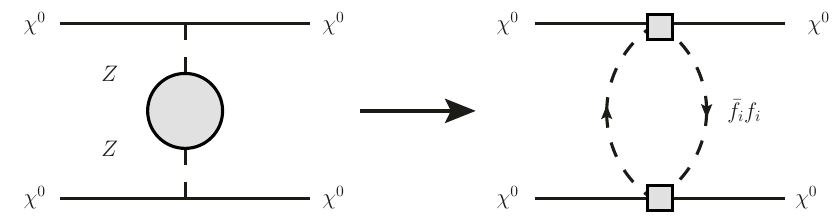
Figure 4 . The relevant one-loop self-energy, that in the large distance, small momentum exchange region, gives the long-range asymptotic (4.19) for δV T 3 T 3 − 2 δV T 3 Y + δV Y Y . In contrast to the T 3 T 3 analogue, discussed on the wino channel χ + χ − → χ + χ − in [19], the beta function behaviour for large and small distances does not change sign for the Y Y correction changes sign in the most relevant region m r ∼ 1 , cf. figure W